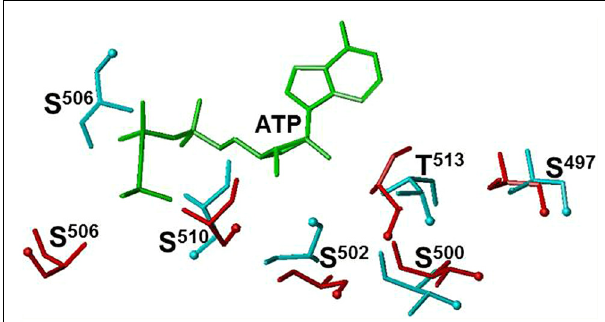
FIGURE 1 |ATP binding to theARM domain affects the conformation of the six phosphorylable residues. The conformation of the six phosphorylated residues is shown before (cyan) and after (red) ATP binding. The ATP molecule is shown in green.The positions of the OH groups are indicated by cyan and red balls (reproduced with permission from ref. Duda etal.,